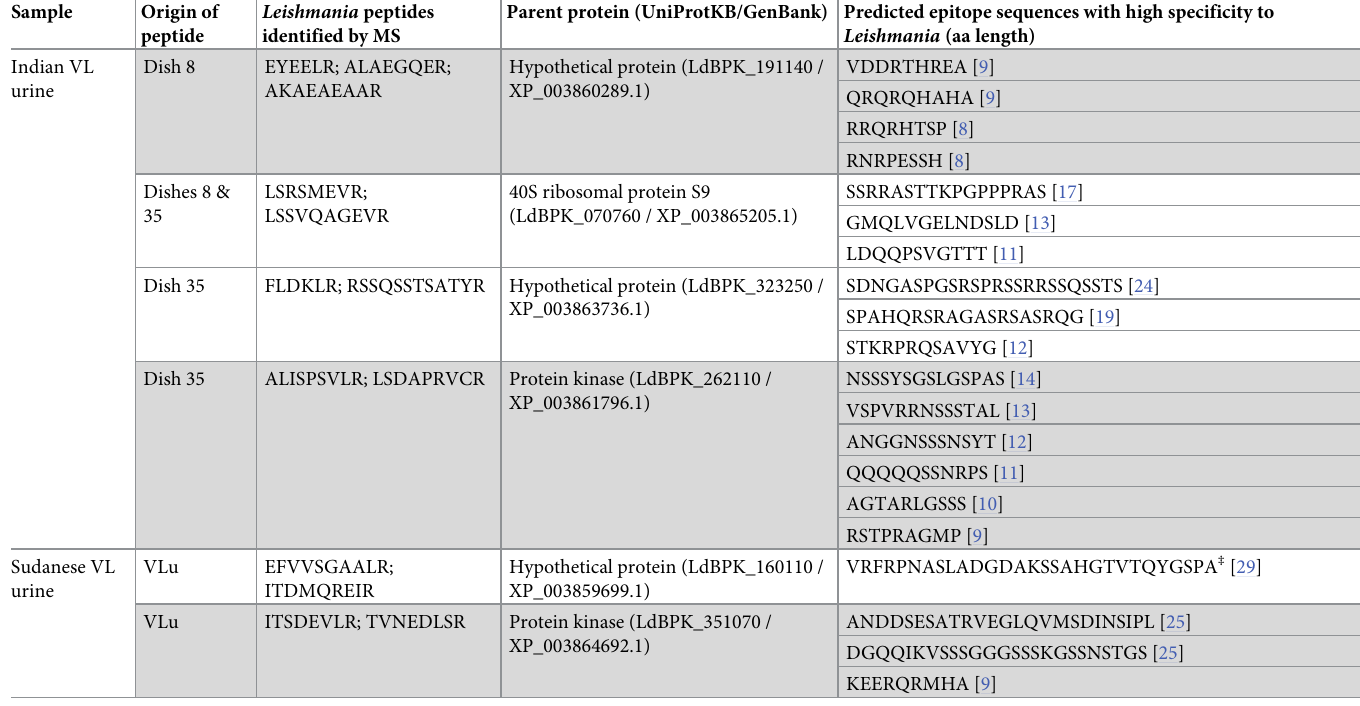
Table 1. Leishmania donovani proteins identified by more than one peptide in urine of Indian and Sudanese visceral leishmaniasis patients. Sample Origin of